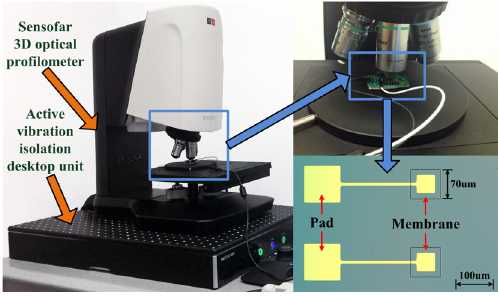
Figure 7. The static deflection testing system.